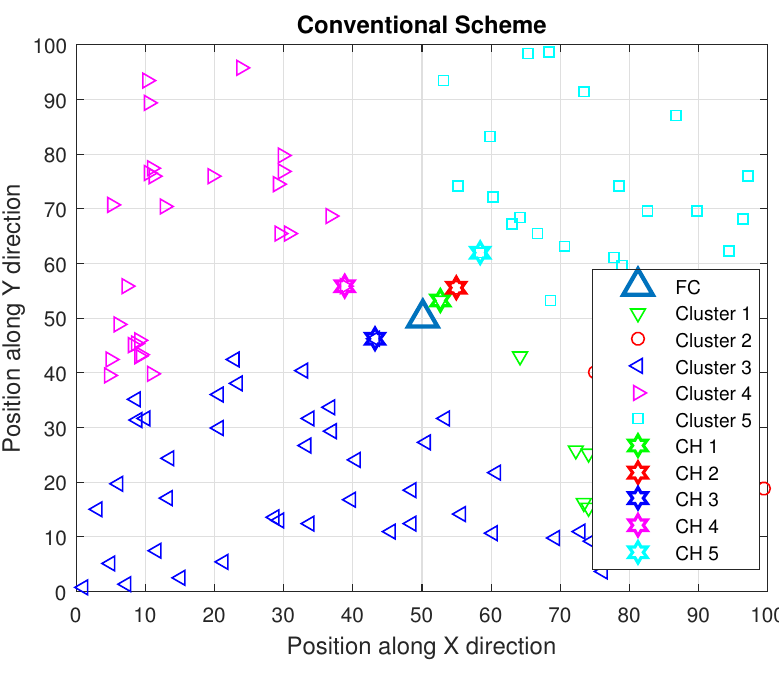
Figure 1. Conventional